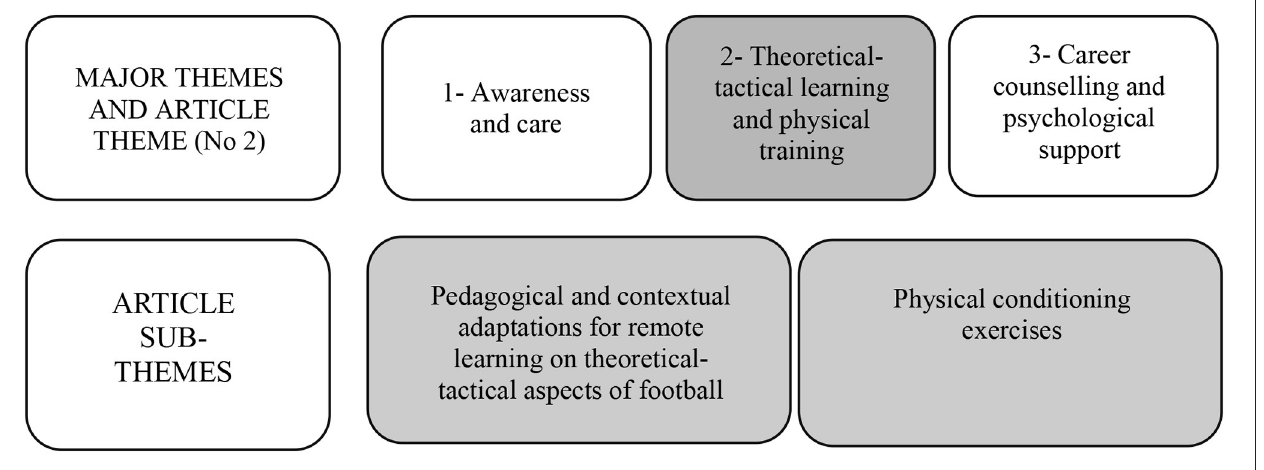
FIGURE 1 | Map of the data analysis